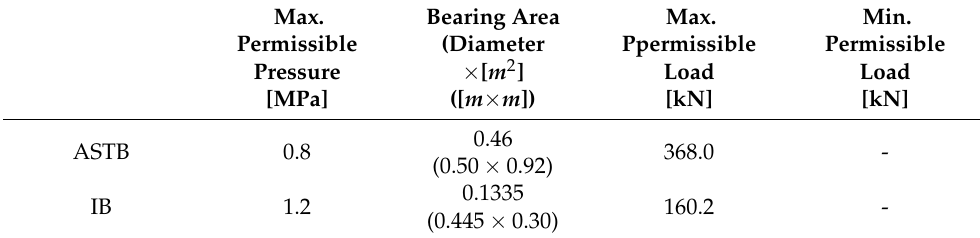
Table 13. Allowable reaction force for bearings according to classification rules (ASTB, IB).